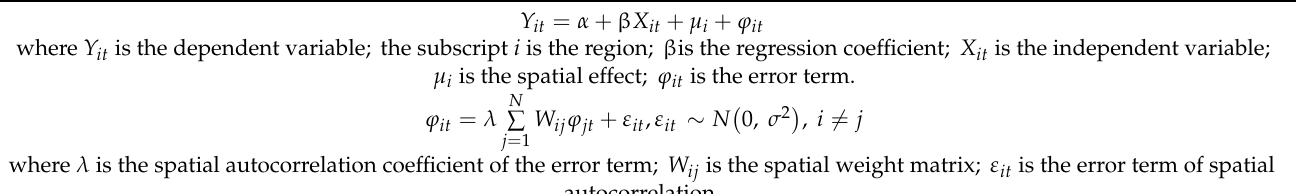
Table 6. The results of spatial error model